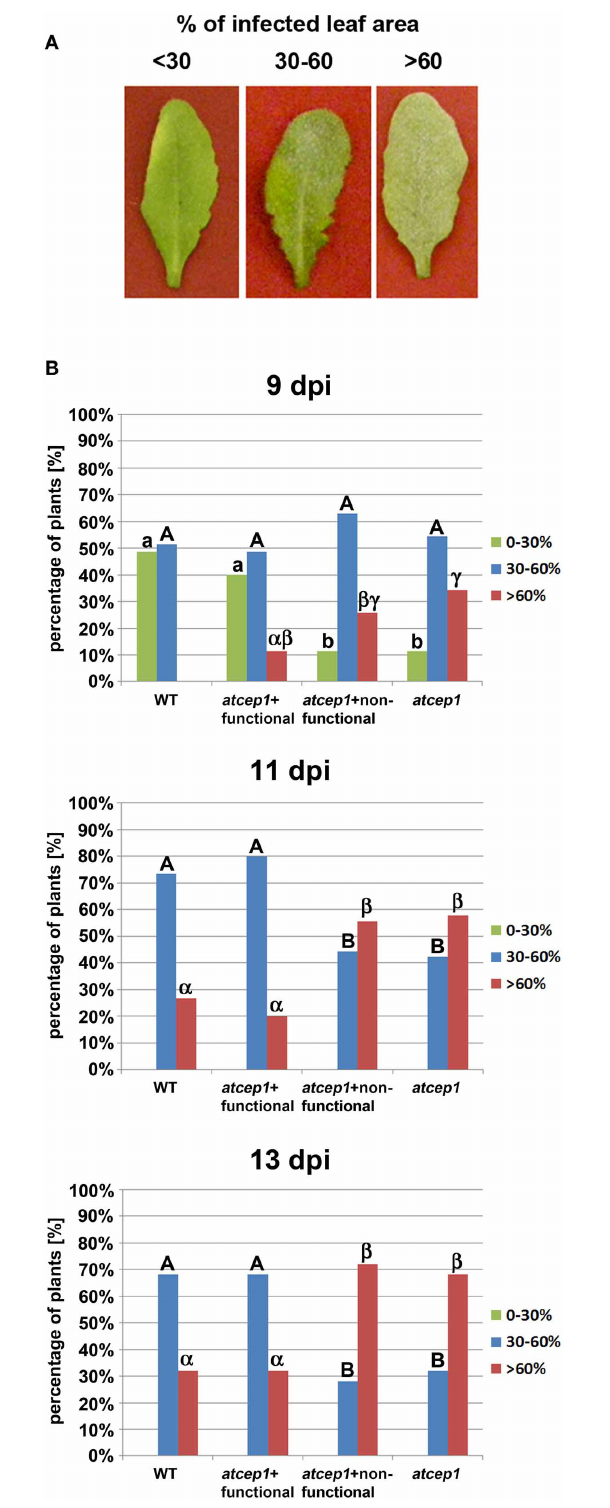
FIGURE 4 | Disease symptoms of wild type and atcep1 mutant plants (SAIL_158_B06) upon leaf infection with Erysiphe cruciferarum spores. Wild type Col0 plants and atcep1 (SAIL_158_B06) plants transformed with